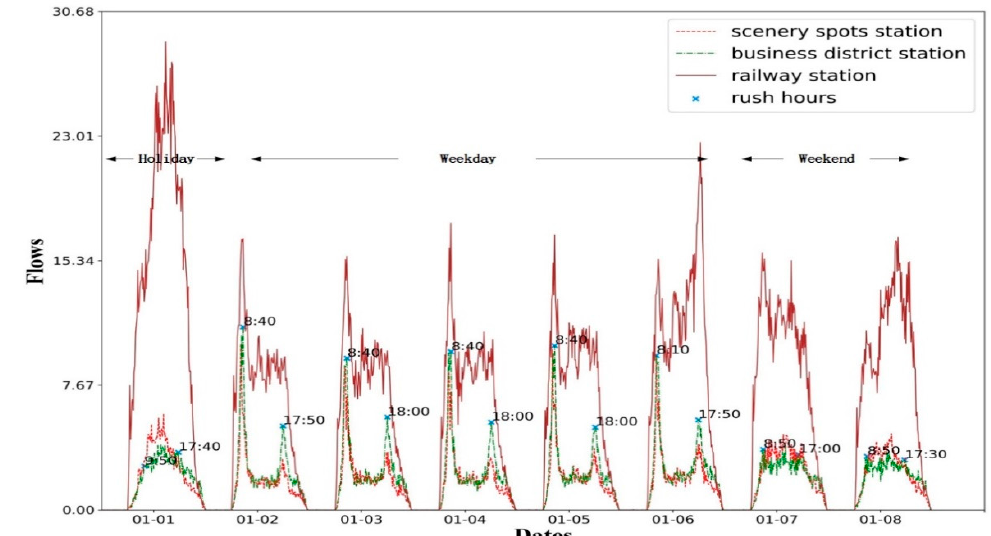
Figure 1. In/Out flow distribution at three different functional stations during the holidays, weekdays, and weekends, where each day consists of 144-time slices with the fixed time interval set as 10 min.